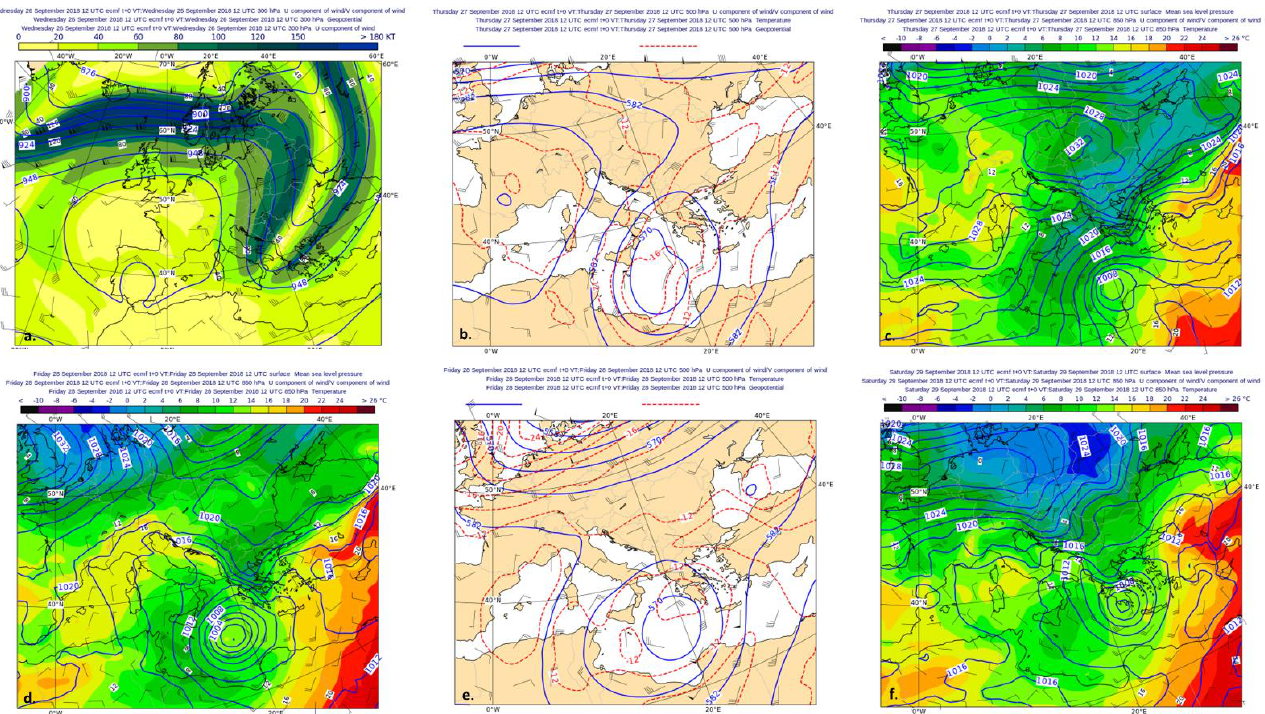
Figure 2. ( a ) 300 hPa geopotential height (continuous lines; in gpdam), isotachs (coloured areas; in knots) and winds at 26/12 UTC, ( b ) 500 hPa geopotential height (continuous lines; in gpdam), temperature (dashed lines; in °C) and winds at 27/12 UTC, ( c ) mean sea level pressure (continuous lines; in hPa), 850 hPa temperature (coloured areas; in °C) and winds at 27/12 UTC, ( d ) mean sea level pressure (continuous lines; in hPa), 850 hPa temperature (coloured areas; in °C) and winds at 28/12 UTC, ( e ) 500 hPa geopotential height (continuous lines; in gpdam), temperature (dashed lines; in °C) and winds at 28/12 UTC, and ( f ) mean sea level pressure (continuous lines; in hPa), 850 hPa temperature (coloured areas; in °C) and winds at 29/12 UTC.